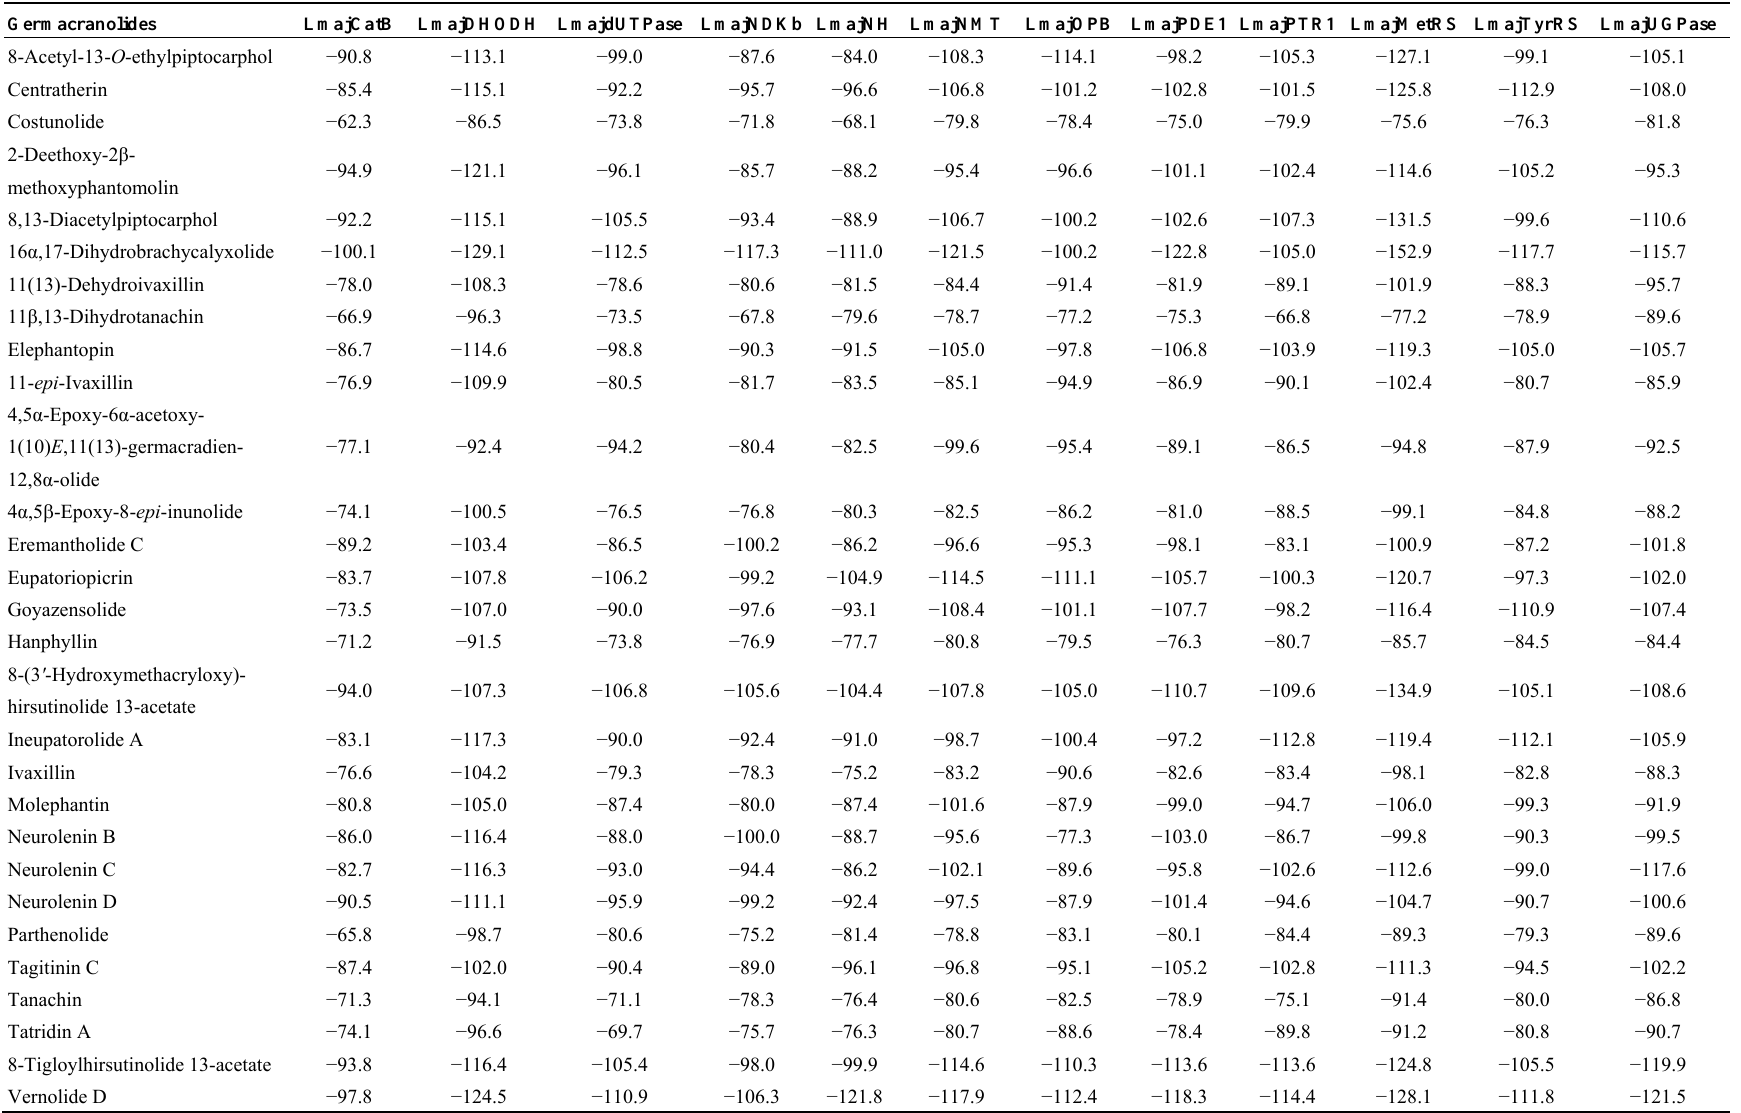
Table 4. MolDock docking energies (kJ/mol) of germacranolide sesquiterpenoids with Leishmania major protein